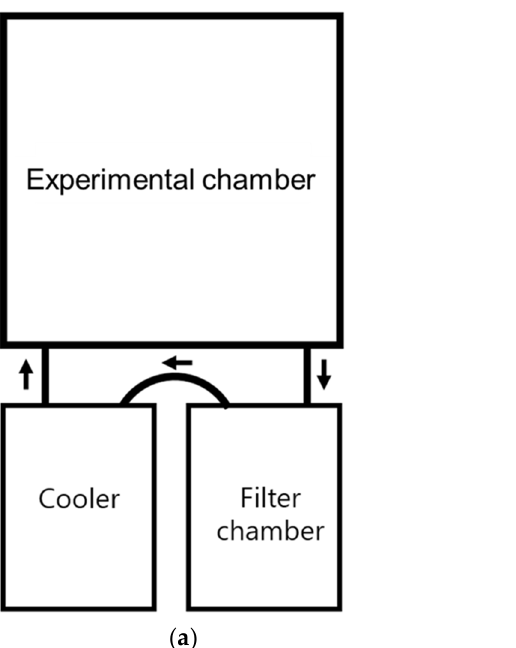
Figure 1. ( a ) Diagram of the experimental setup and ( b ) diagram of each experimental